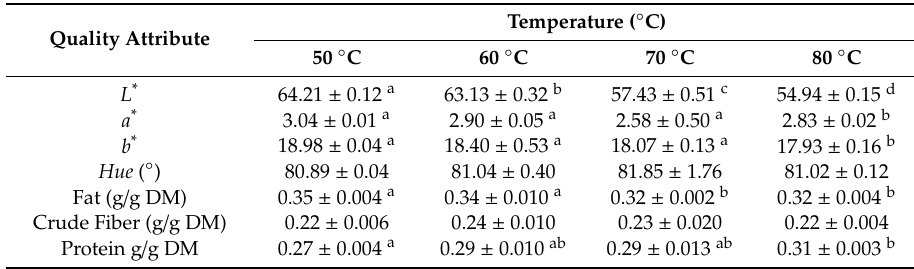
Table 5. Comparison of selected quality attributes and proximate composition of pumpkin seed powders obtained from seeds dried at 50 to 80 ◦